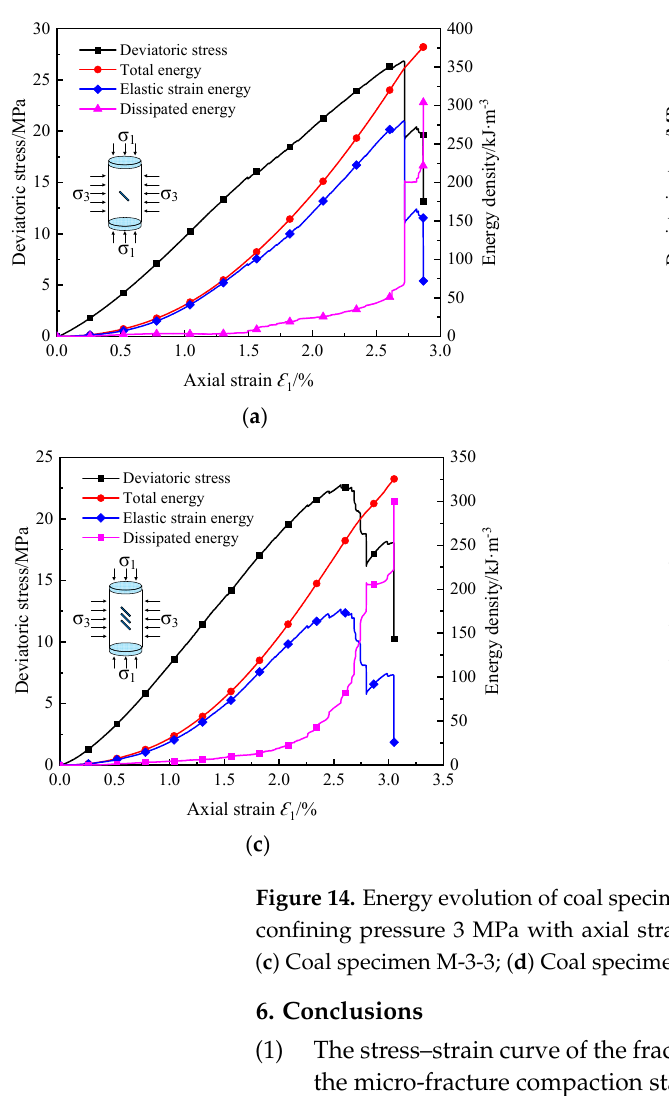
Figure 13. Energy evolution of coal specimens with different numbers of prefabricated cracks under confining pressure 0.3 MPa with axial strain. ( a ) Coal specimen M − 0.3 − 1; ( b ) Coal specimen M − 0.3 − 2; ( c ) Coal specimen M − 0.3 − 3; ( d ) Coal specimen M − 0.3 − 4.